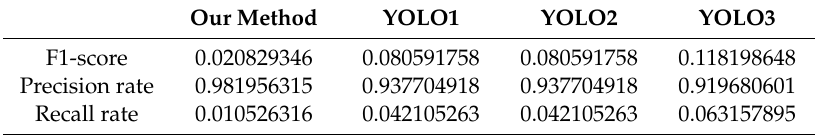
Table 9. F1-score, precision rate, recall rate of training data.